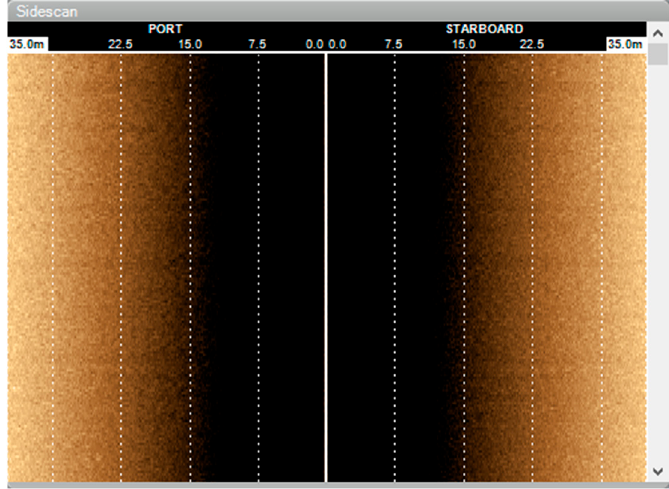
Figure 9. Electrical isolation with cables routed closely.